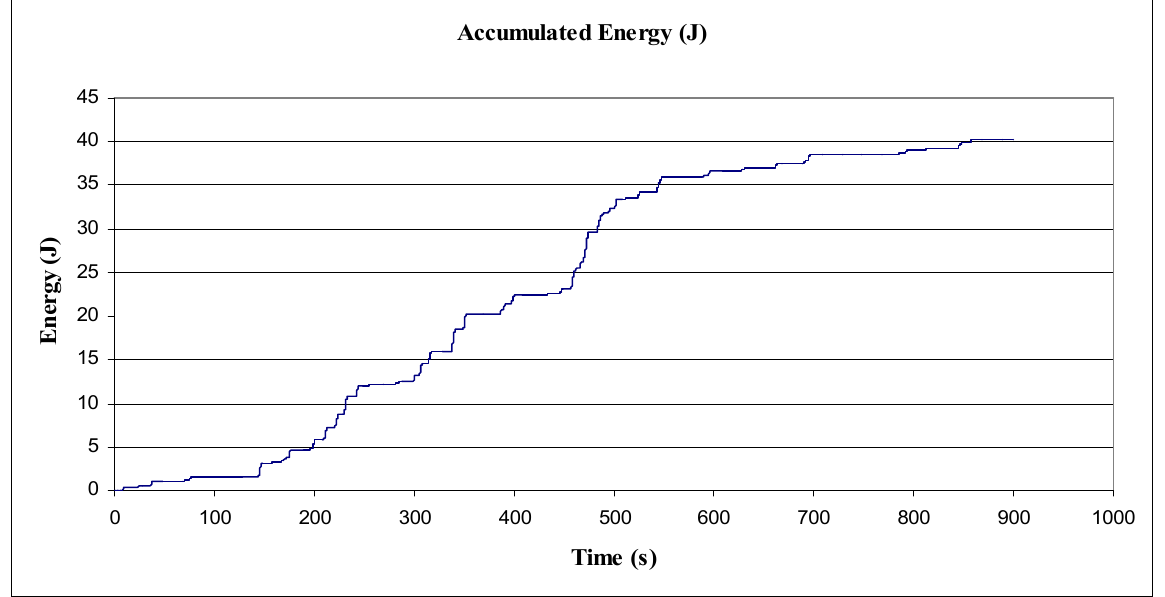
from lifting suspended mass. MOV